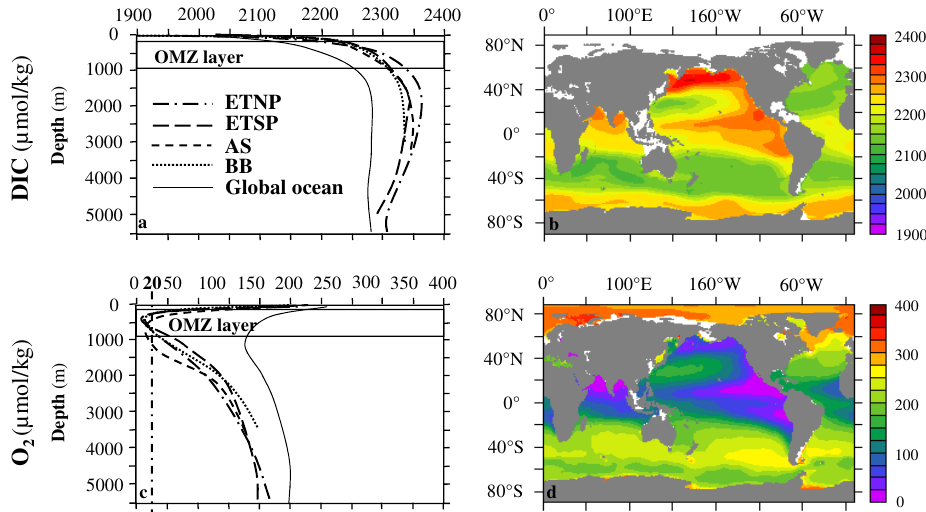
Fig. 2. Vertical profiles of DIC (a) and O 2 (c) on 0–5500m for the main most intense OMZs in the open ocean from GLODAP and WOA2005 databases. The continuous profile in (a) and (c) corresponds to a mean global profile from the all available datasets both in and out the OMZs. Vertical dashed line in (c) corresponds to O 2 = 20µmolkg − 1 (upper O 2 concentrations of the OMZs core), and horizontal continuous lines in (a and c ) correspond to the mean upper (175m) and lower (950m) depths of the OMZs core. Mean DIC (b) and O 2 (d) distribution average inµmolkg − 1 on the 175–950m, a layer intercepting the core of all main tropical OMZs (cf. Table 1). For ETNP, ETSP, AS and BB, same abbreviations than in Table 1